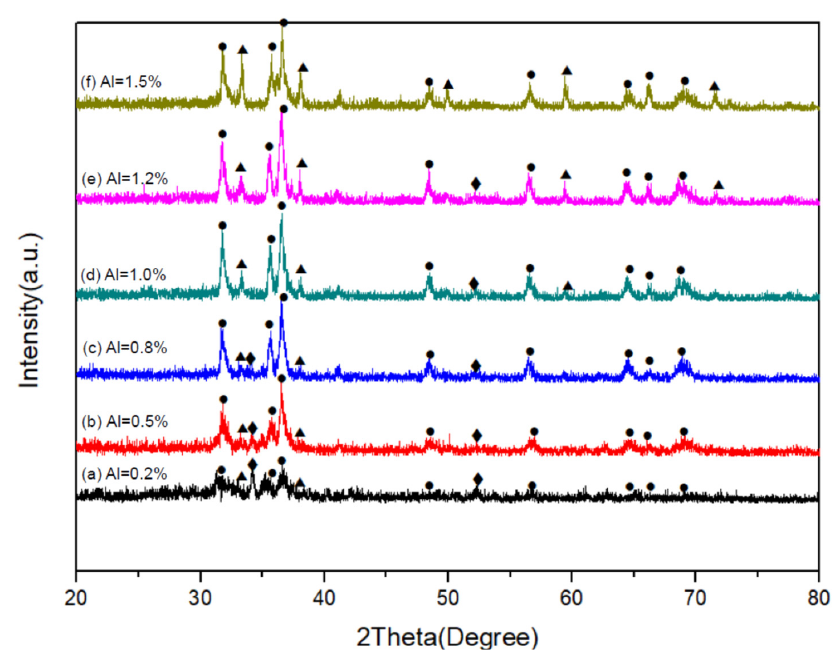
Figure 1. XRD patterns of the as-synthesized products obtained with Al = 0.2 ( a ); 0.5 ( b ); 0.8 ( c ); 1.0 ( d ); 1.2 ( e ); and 1.5 ( f ).